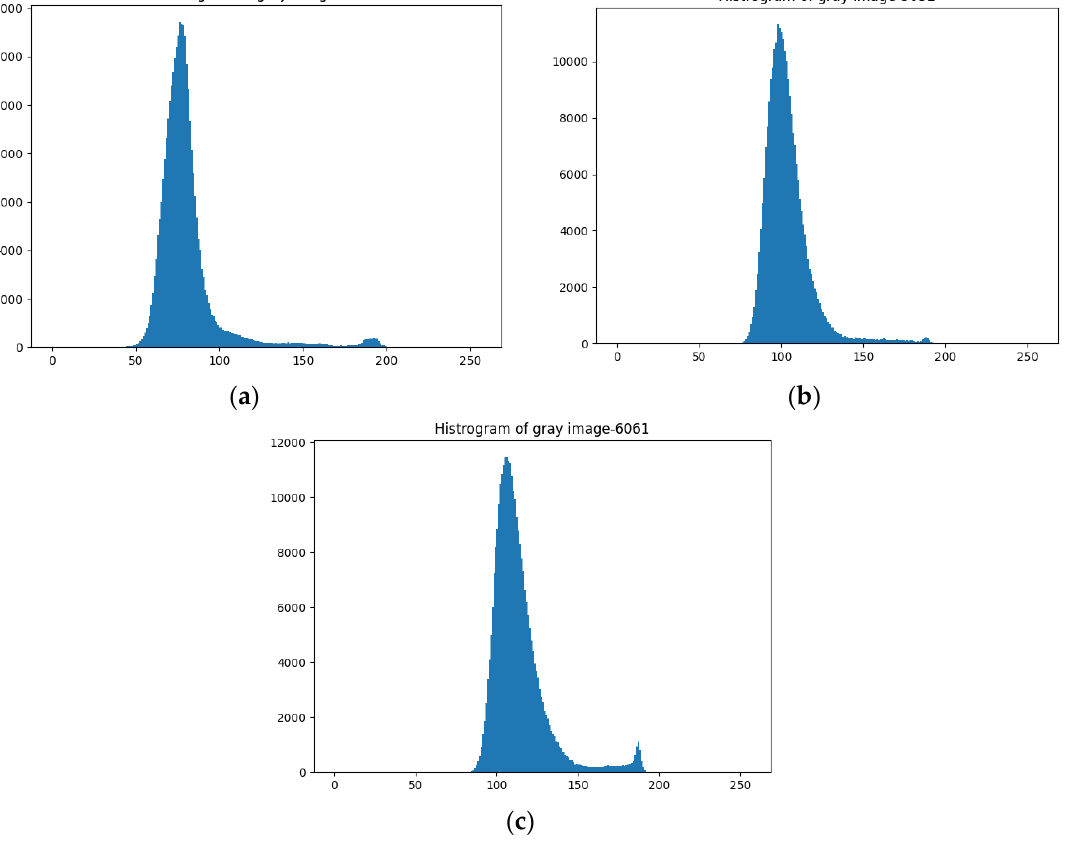
Figure 9. ( a ) Grayscale histogram of 1060; ( b ) Grayscale histogram of 5052; ( c ) Grayscale histogram of 6061.